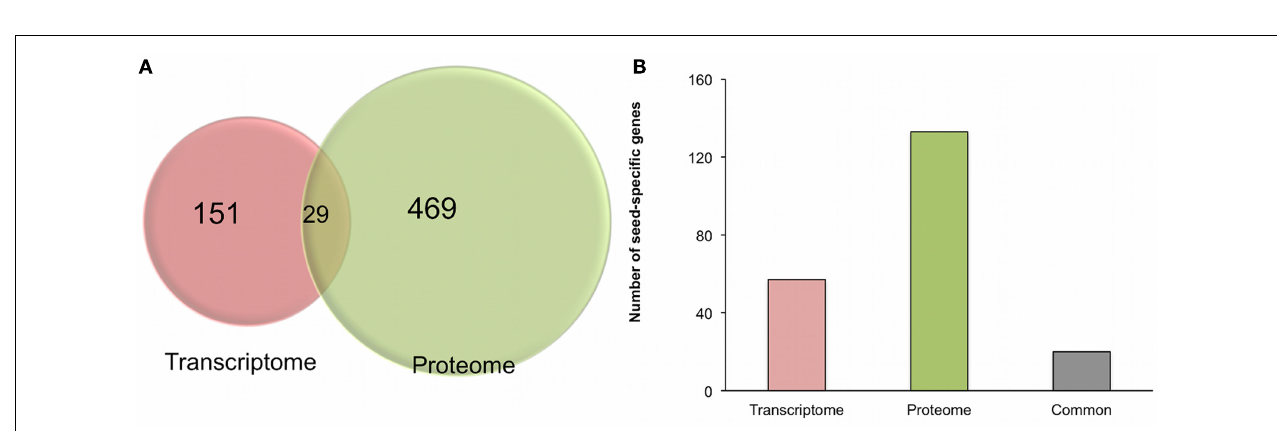
data from Nakabayashi et al. (2005). For these 218 proteins, the log2 ratio between 0 and 24h of seed germination was calculated for both transcript and protein.The corresponding values were then plotted and a correlation coefficient (indicated on the graph) was calculated from the linear regression.